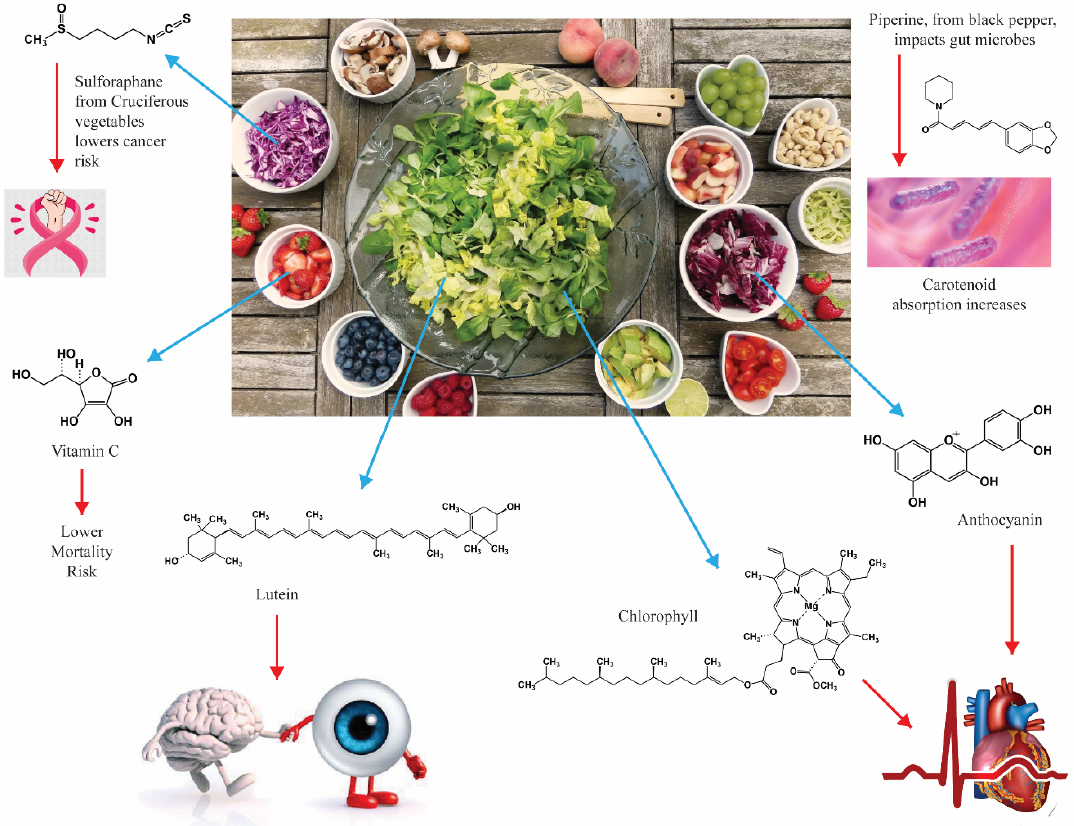
Figure 1. Various phytochemicals and known health benefits.